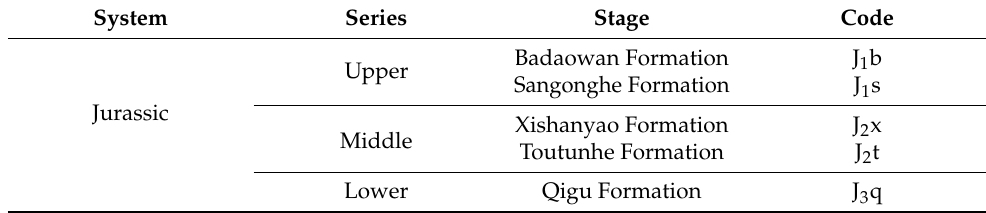
Table 1. General stratigraphy of the study area.